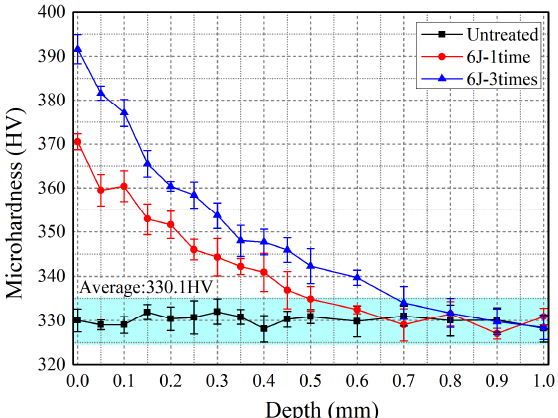
Figure 6. In-depth microhardness distribution of experimental coupons before and after the LSP treatment for 6J-1time and 6J-3times.